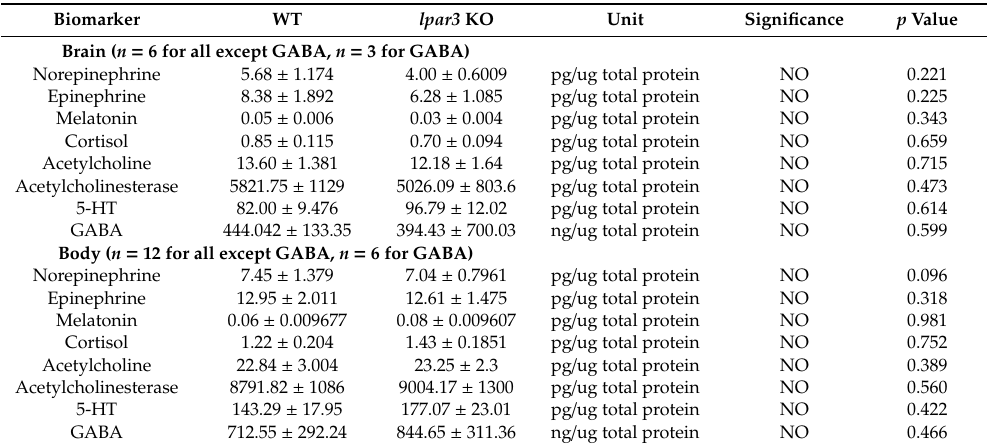
Table 1. Expression of stress hormones and neurotransmitters in the brain and other body parts in wild-type and lpar 3 knockout zebrafish at the adult stage. Data are presented as means ± standard error of the mean (SEM) and the significant di ff erence was tested by t-test.